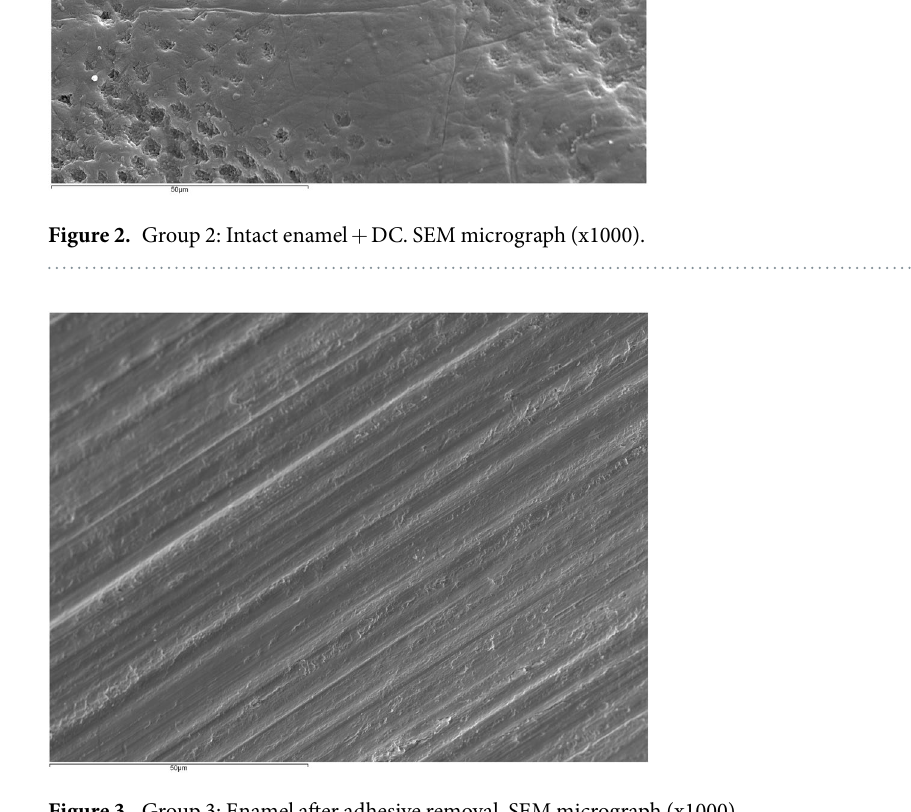
Figure 3. Group 3: Enamel after adhesive removal. SEM micrograph